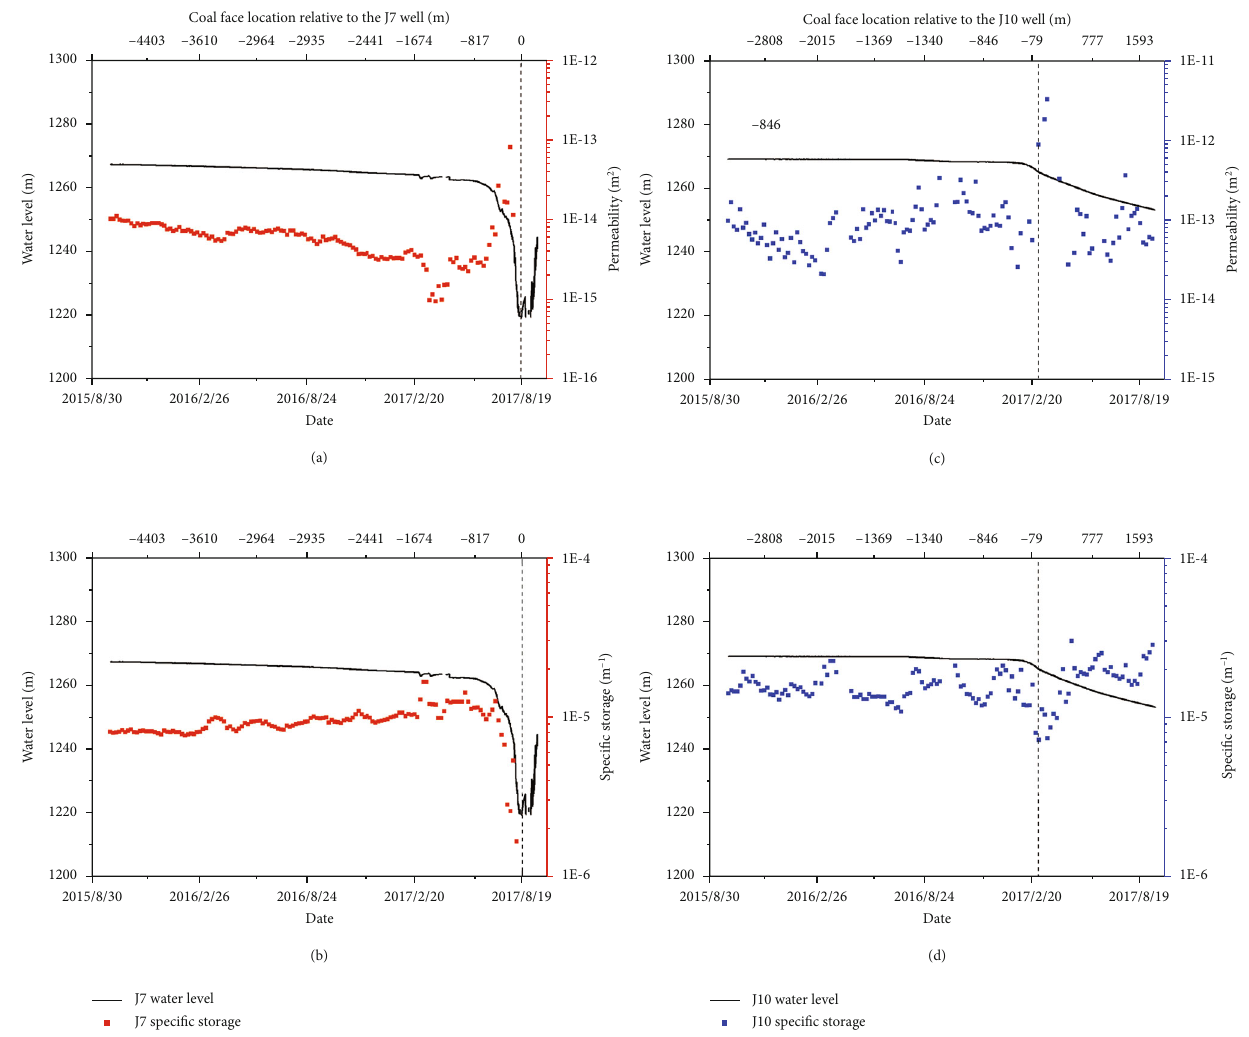
Figure 9: Variations of water level, permeability, and speci fi c storage of J7 and J10 as a function of longwall coal face location relative to borehole location. Negative values represent a coal face location before it reaches the borehole location, where positive values represent the location of the coal face after undermining. The dash lines show the times when the longwall excavation zone is closest to the J10 and J7 wells,